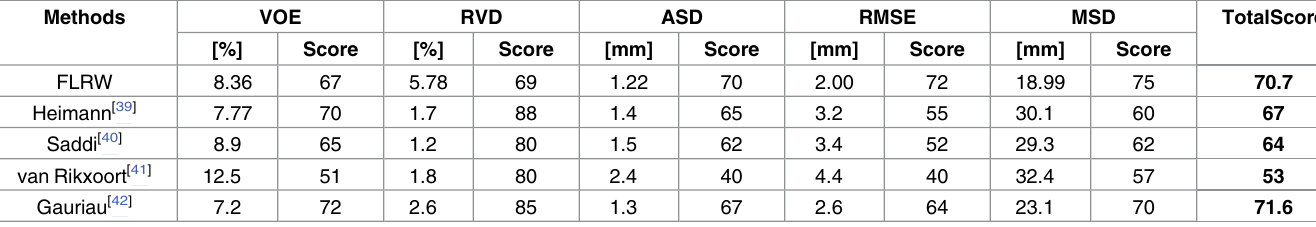
Table 5. The score comparisons of different automatic methods with MICCAI database. Methods